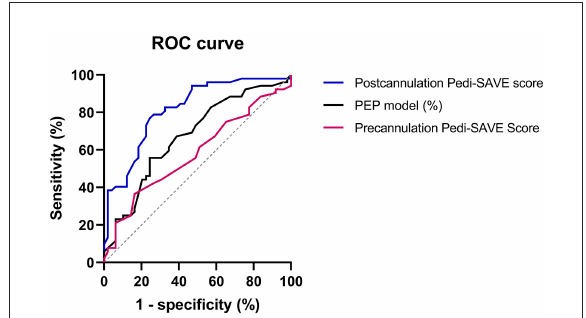
FIGURE2 The receiver operating characteristic curve of prediction scores. ROC, receiver operating characteristic; PEP, Pediatric Extracorporeal Membrane Oxygenation Prediction; Pedi-SAVE, Pediatric Survival After Veno-arterial Extracorporeal Membrane Oxygenation; ECMO, extracorporeal membrane